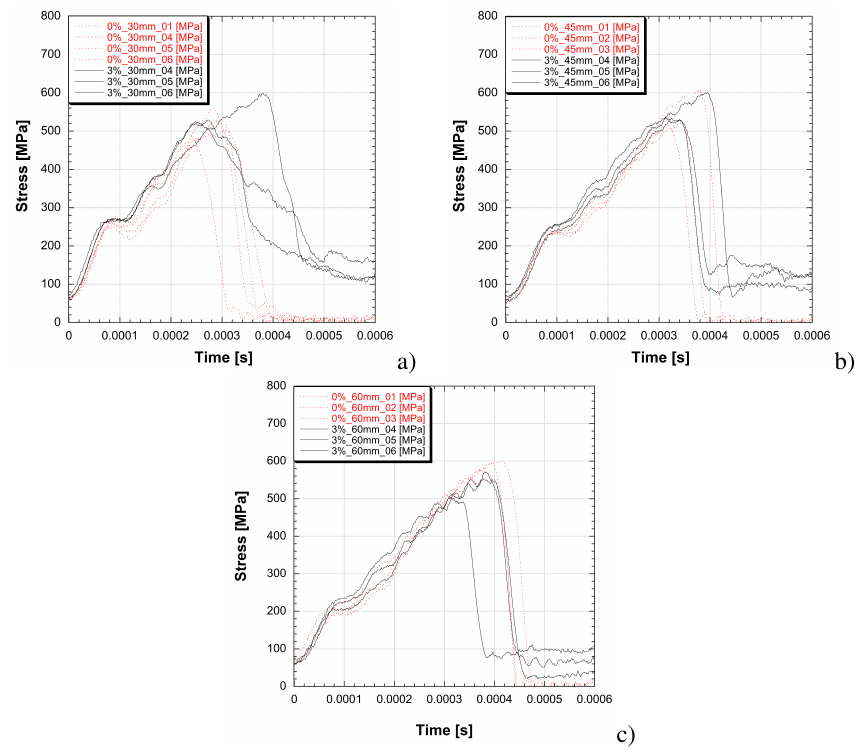
Figure 4. Comparison between UHPFRC and UHPC stress versus time curves: a) 30mm; b) 45mm and c) 60mm